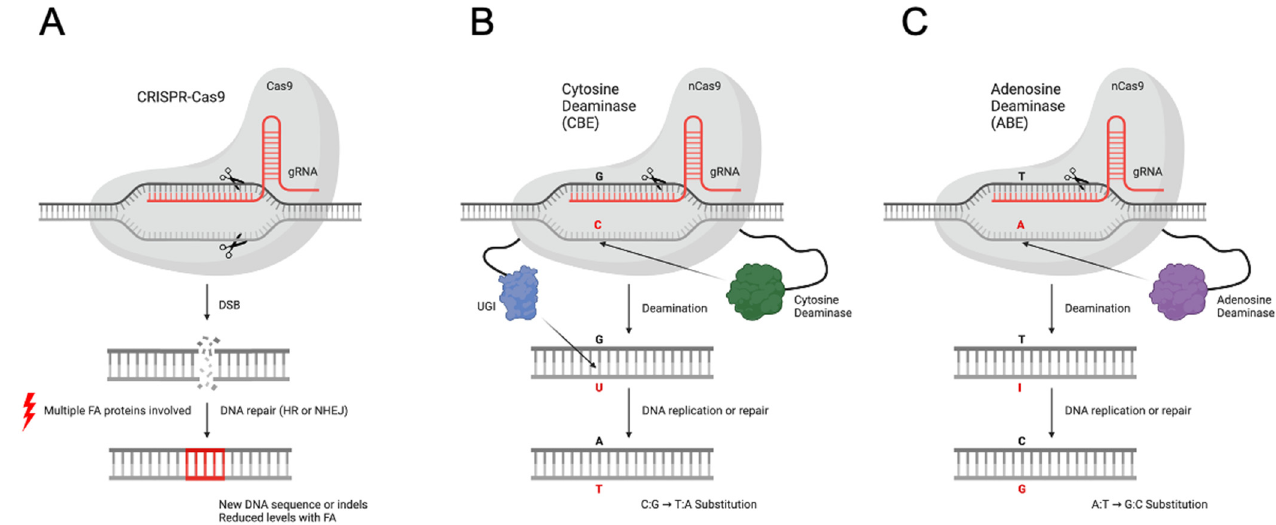
Figure 1. Bypassing DSB induction with base editor technology is ideal for FA gene therapy. ( A ) CRISPR-Cas9 produces DSBs that are difficult for FA-mutated cells to resolve during gene therapy; a designed sgRNA complex with Cas9 nuclease which localizes and binds to the complemen- tary target site. Cas9 creates a DSB in the DNA that the cell resolves through the error prone NHEJ pathway or the HDR pathway, although to reduced levels in FA-mutated cells. ( B ) CBE; nCas9, which instead only nicks the opposite target stand, induces a DNA repair pathway response. The target C in the editing window is deaminated by a fused APOBEC1 protein to a U, and a fused uracil glycosylase inhibitor (UGI) protein prevents the cell from resolving this mismatch through the BER pathway. During DNA replication or repair, the U matches with an A resulting in a C/G to T/A substitution. ( C ) ABE; nCas9, which also only nicks the opposite target stand, induces a DNA repair pathway response. The target A in the editing window is deaminated by a fused TadA protein to an inosine, I. During DNA replication or repair, the I is read as a G resulting in an A/T to G/C substitution.